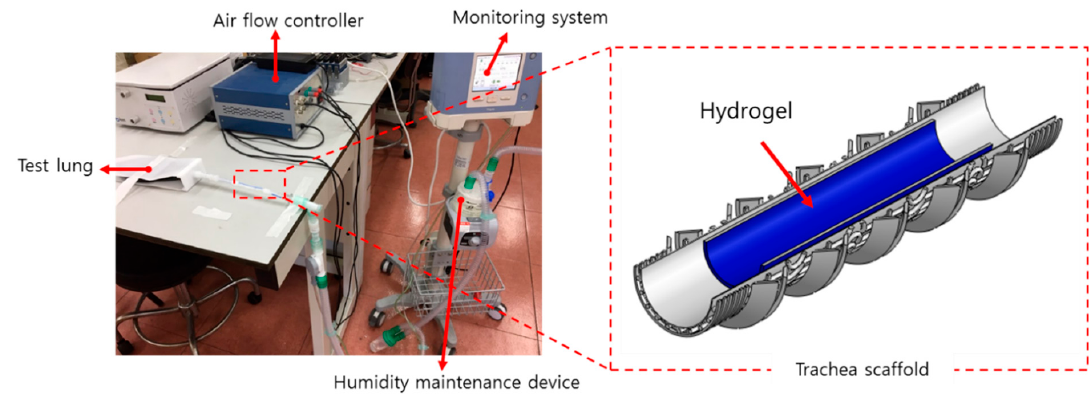
Figure 6. Configuration and experimental condition for the ventilation system.